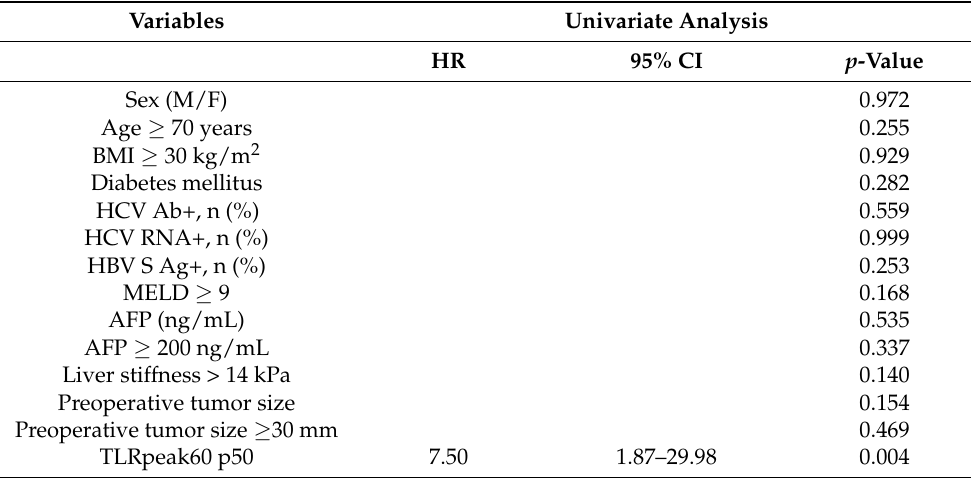
Table 5. Predictors of microvascular invasion or a high grade of differentiation (G3 or G4) using data available before a liver